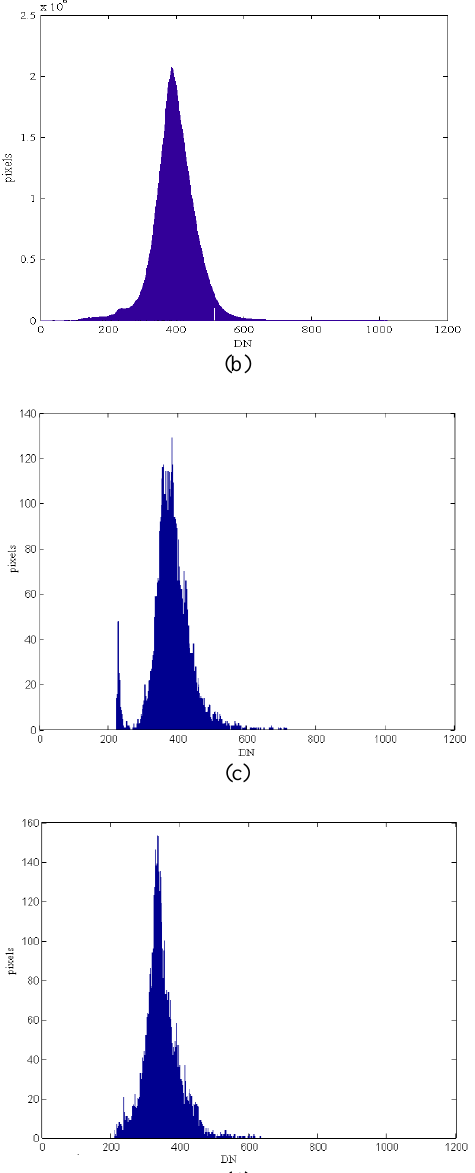
Figure 1 (a) one 0-level panchromatic images of SJ-9A satellite,(b) histogram of whole image,(c)histogram of pixel 2000,(d)histogram of pixel 3800 The shape of histogram distribution is invariant but has motion of translation,which is caused by obvious grey level change of mosaic area. The centroid of histogram is introduced to represent this difference,which can be written